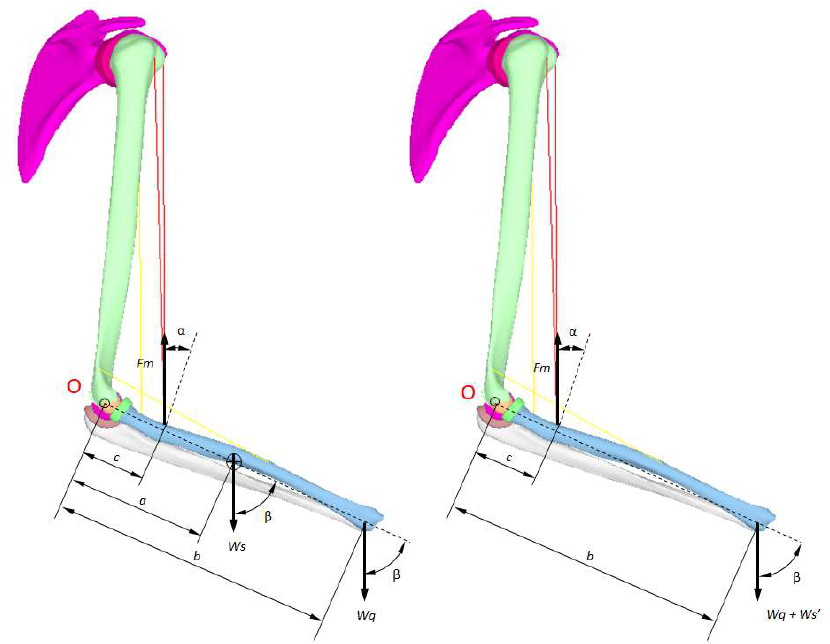
Figure 10. Forces scheme in elbow joint.